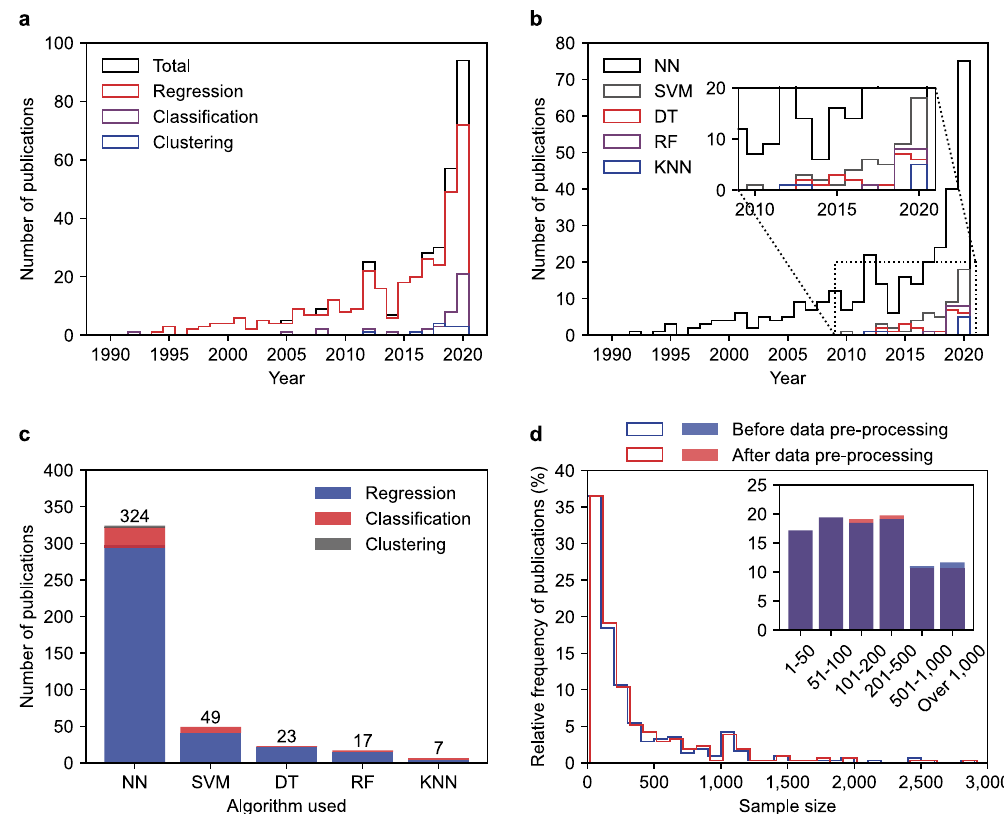
Fig. 2 Data characteristics from the literature survey of 389 peer-reviewed publications on machine learning for concrete science. a – d , Number of publications based on publication year ( a , b ); algorithm used (overlapped regions in the bar ‘ NN ’ indicate that publications of interest include both regression and classi fi cation tasks or both classi fi cation and clustering tasks) ( c ); and sample size (presented as relative frequency with a fi xed bin width of 100 or unequal bin sizes (inset); only for publications with regression tasks; maximum values were selected if more than one dataset was used in a publication) ( d ). Data source: Web of Science; period: 1990 – 2020; survey criteria and collected data can be found in Supplementary Note 1 and Supplementary Dataset, respectively. NN neural network, SVM support vector machine, DT decision tree, RF random forest, KNN, k -nearest